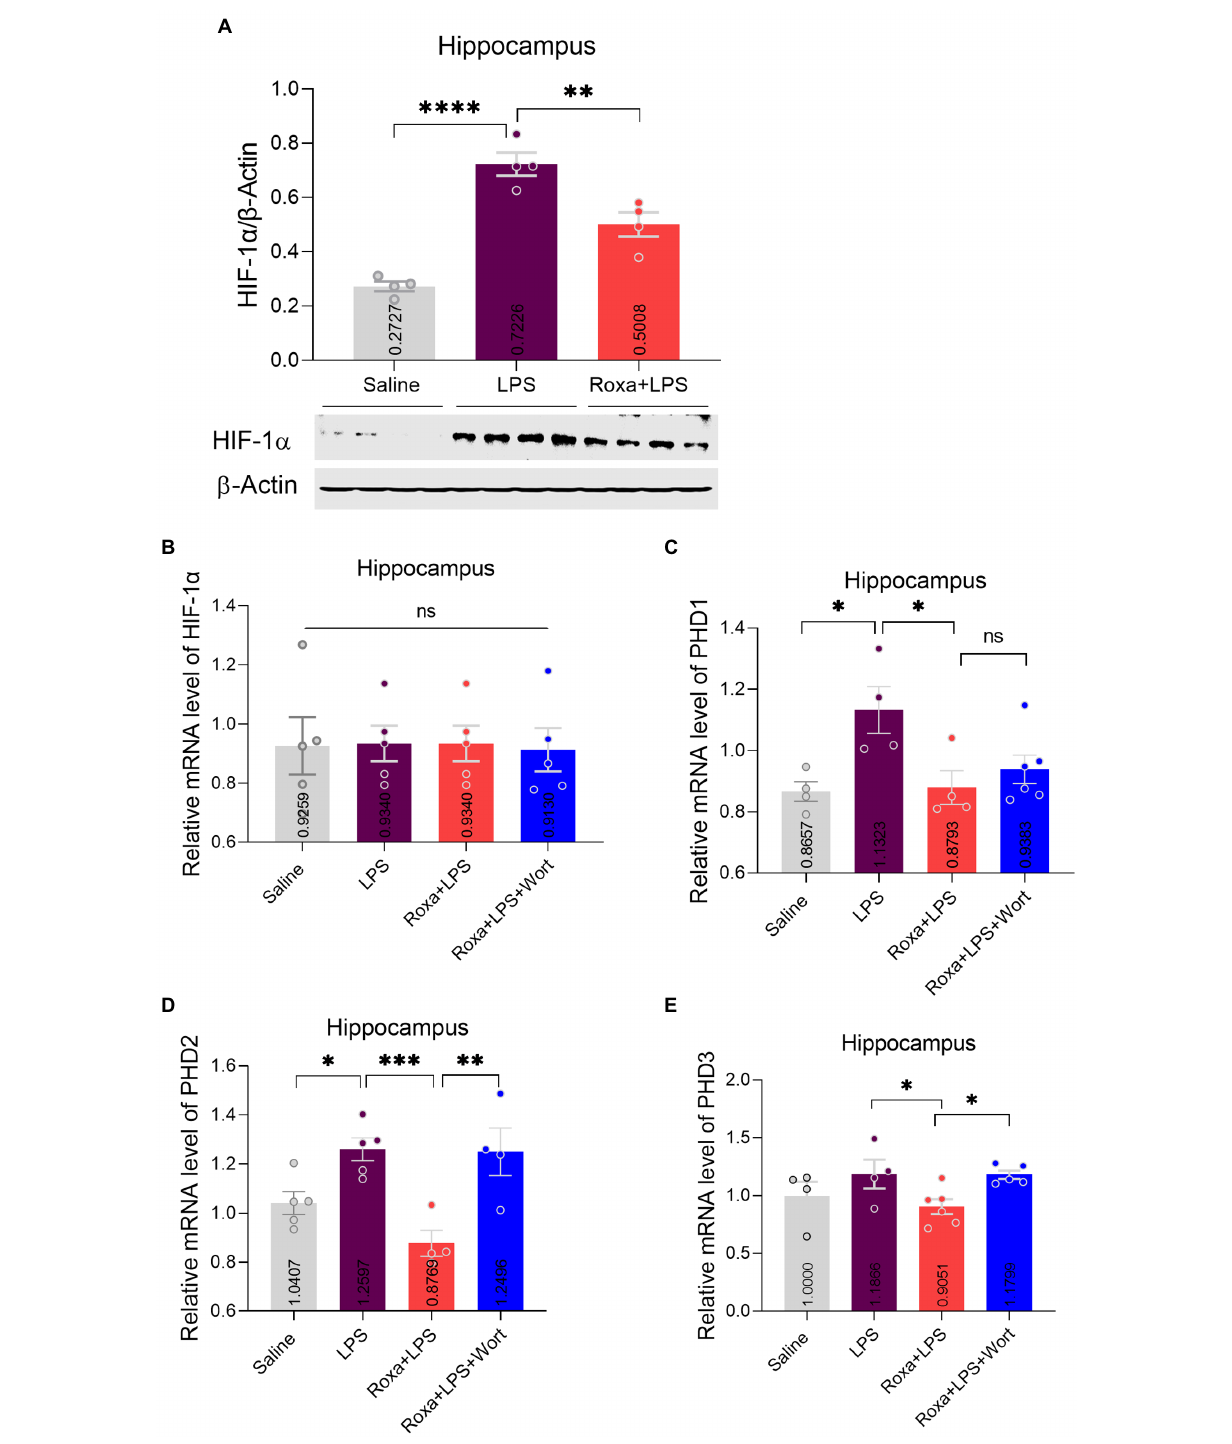
FIGURE 2 Roxadustat effects on HIF-1a and PHDs expression. (A) Representative immune blot images and average protein levels of HIF-1 levels were normalized with β -Actin. (B–E) Showing mRNA levels of HIF-1, PHD1, PHD2, and PHD3. Image lab software was used for quantitative blot analysis and was analyzed via GraphPad prism. Data were expressed as mean ± SEM, One-way ANOVA, followed by post hoc analysis. p = <0.05 were considered significant. * p < 0.05, ** p < 0.01, *** p < 0.001, **** p < 0.0001. ns: